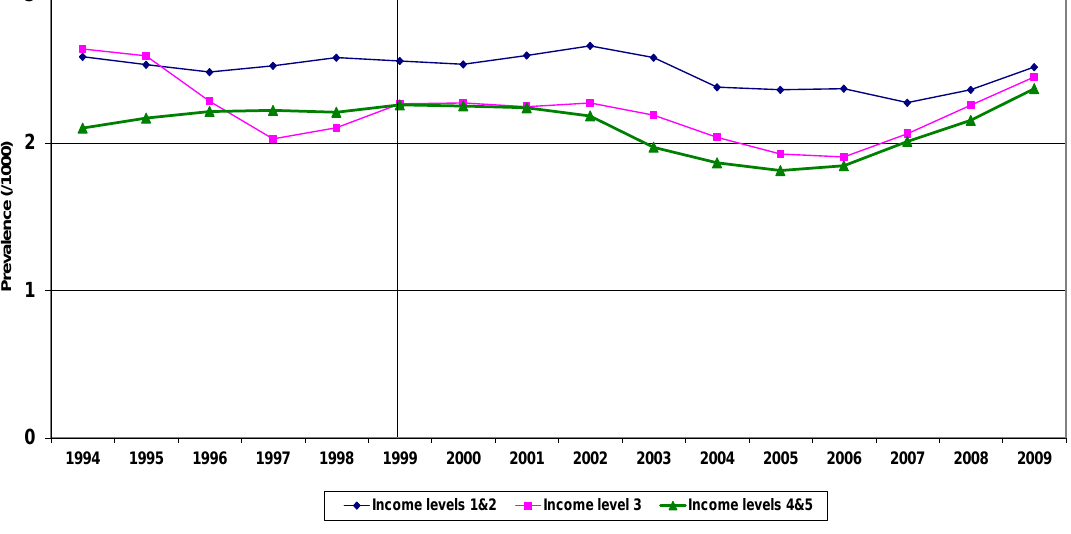
* Standardized for maternal age. Vertical line indicates the onset of food fortification with folic acid.